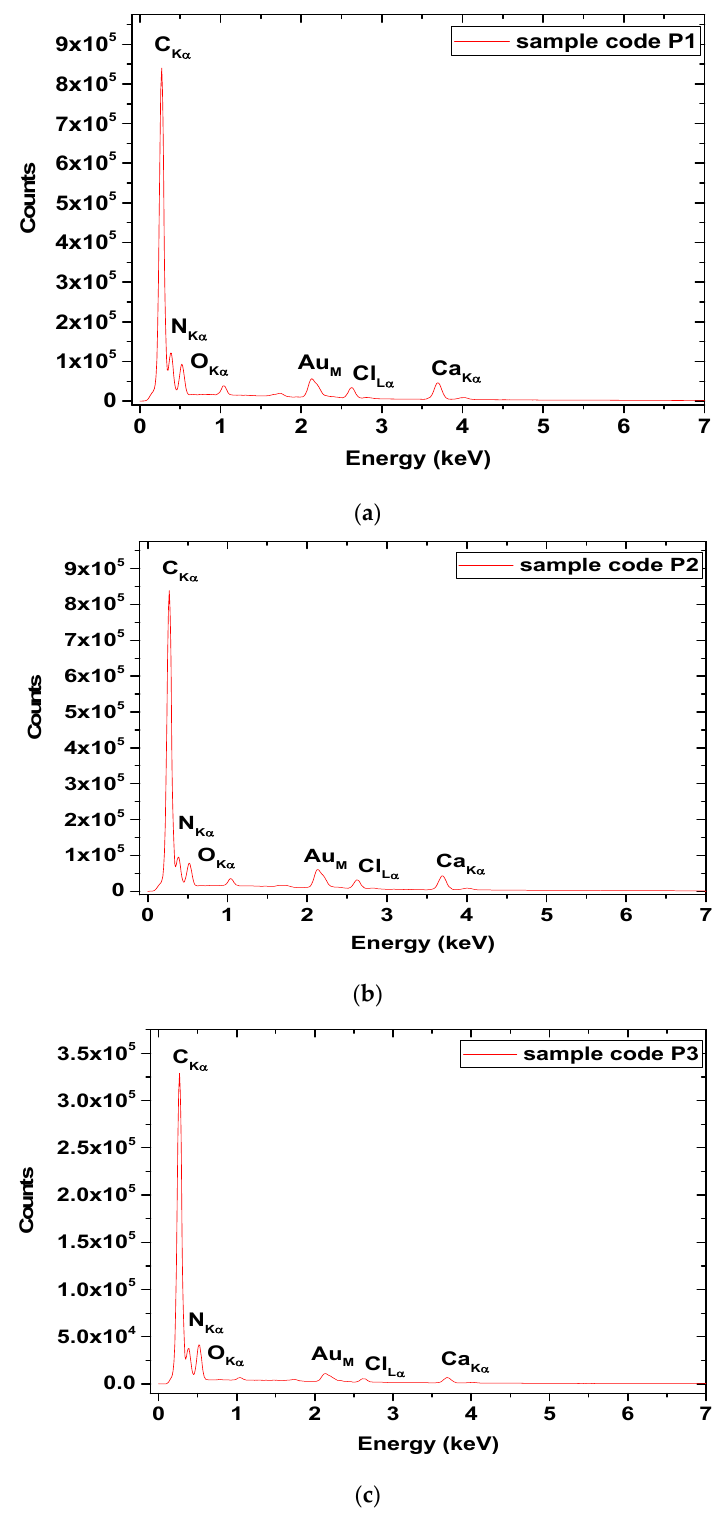
Figure 7. EDX analyses for the P1 ( a ), P2 ( b ) and P3 ( c ) electrospun samples.